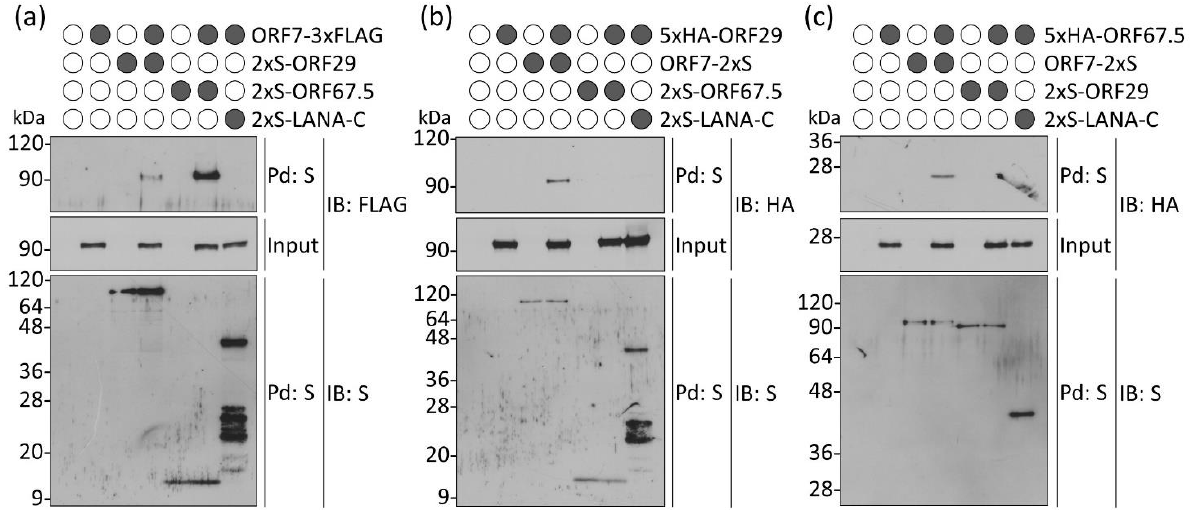
Figure 5. ORF7 functions as a hub molecule for interactions between ORF29 and ORF67.5. ( a ) ORF7 interacted with ORF29 and ORF67.5. HEK293T cells were cotransfected with plasmids expressing ORF7-3xFLAG and either 2xS-ORF29 or 2xS-ORF67.5. Cell lysates prepared at 18 h post-transfection were subjected to a pulldown assay (Pd) using S-protein beads. The precipitated 2xS-ORF29 or 2xS-ORF67.5 was analyzed by immunoblotting (IB) using anti-FLAG antibody to detect ORF7-3xFLAG. ( b ) ORF29 interacted with ORF7 but not ORF67.5. Cells were cotransfected with 5xHA-ORF29 and either ORF7-2xS or 2xS-ORF67.5 plasmids. The precipitated ORF7-2xS or 2xS-ORF67.5 was analyzed by IB using anti-HA antibody to detect 5xHA-ORF29. ( c ) ORF67.5 interacted with ORF7 but not ORF29. Cells were cotransfected with 5xHA-ORF67.5 and either ORF7-2xS or 2xS-ORF29 plasmids. The precipitated ORF7-2xS or 2xS-ORF29 was analyzed by IB using anti-HA antibody to detect 5xHA-ORF67.5. ( a – c ) “Input” means total cell lysates, and 2% cell lysates used for pulldown were applied for SDS-PAGE. 2xS-LANA-C plasmid (KSHV ORF73/LANA 954-1162 C-terminal end) was used for the negative control for ORF7 binding. Original images of blotting are shown in Supplementary Figures S3 to S5.